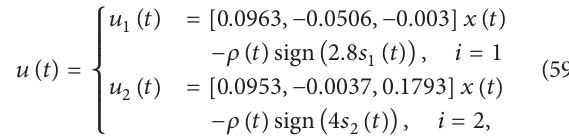
Take 𝜌 1 = 𝜌 2 = 0.64 , then the SMC law designed in (51) can be described